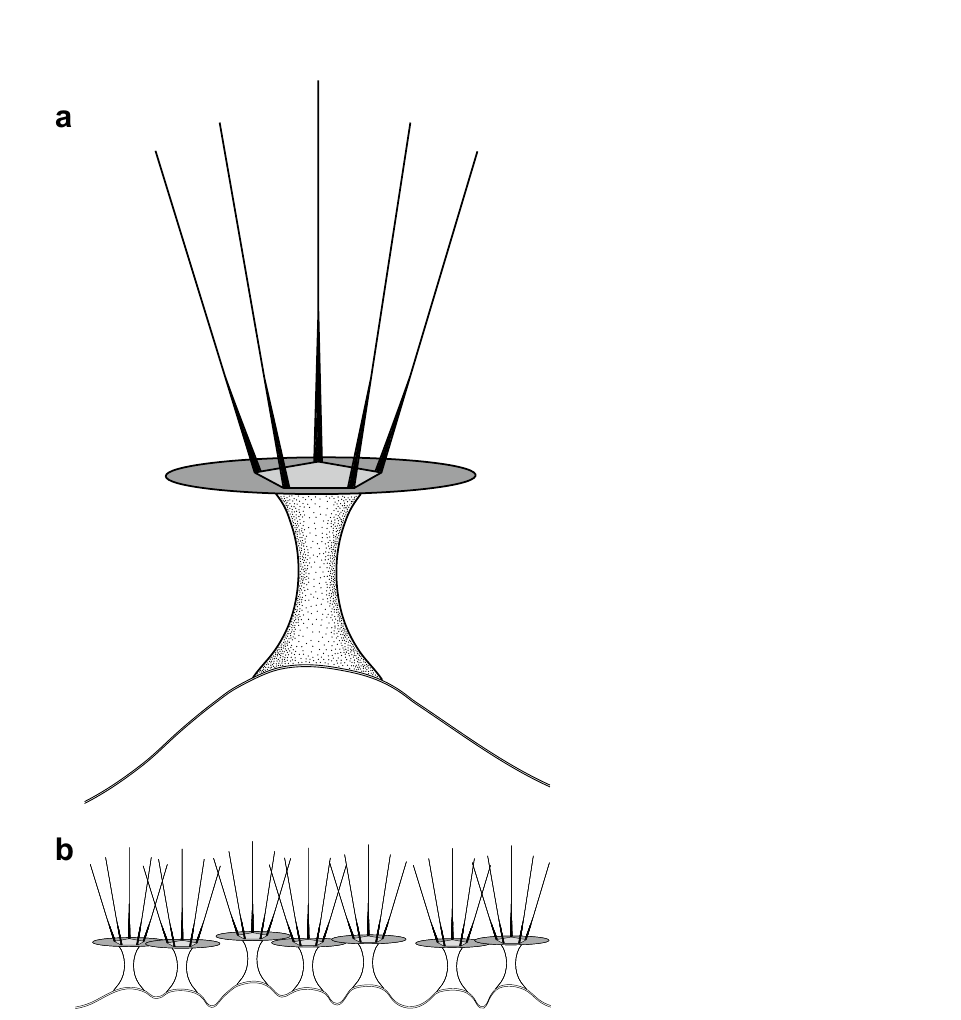
Figure 3. Diagram representing the reconstruction of the cell coat in Coronamoeba villafranca gen. nov. sp. nov. ( a ) Individual cell coat unit on the plasma membrane. ( b ) Scheme of the location of the cell coat units on the plasma membrane